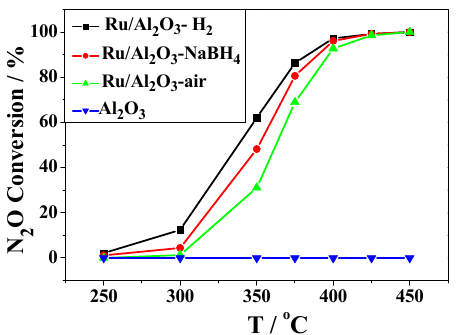
Figure 4. N 2 O conversion as a function of reaction temperature over fresh Ru/Al 2 O 3 catalysts (reaction condition: [N 2 O] = 5000 ppm and gas hourly space velocity (GHSV) = 11,000 h − 1 ).